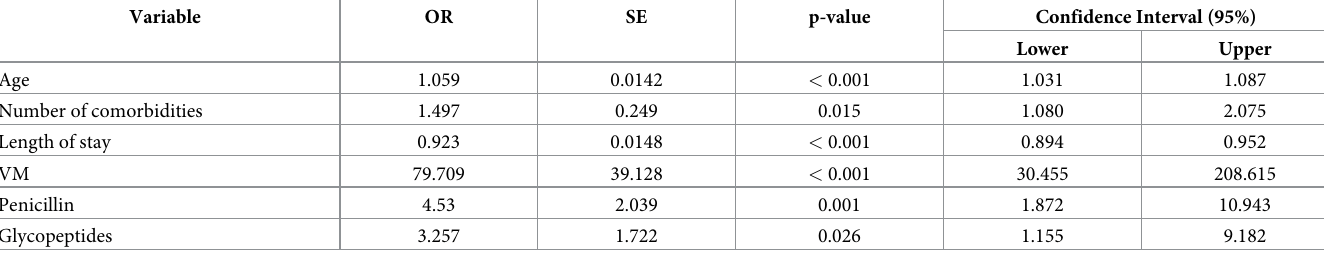
Table 3. Multivariate logistic regression analysis of risk factors for mortality in hospitalized patients with COVID-19. Variable